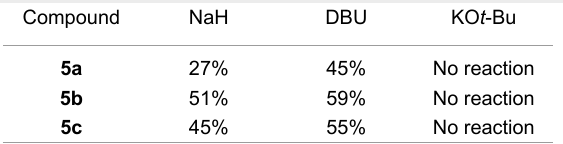
Table 2: Effect of temperature on the yield of compounds 5a , 5b and 5c a .